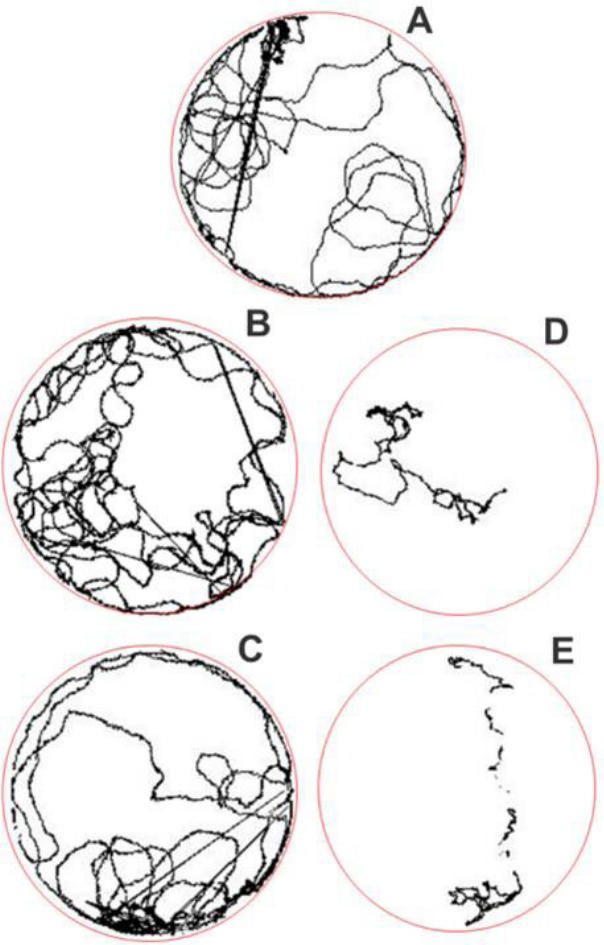
Fig 2. Most representative trails of Inquilinitermes microcerus workers in the following treatments: A) inquiline workers alone, B) inquiline workers with host workers from the same nest, C) inquiline workers with host workers from different nest, D) inquiline workers in contact with substrate from the inner wall of host nest and E) inquiline workers in contact with substrate from the external wall of host